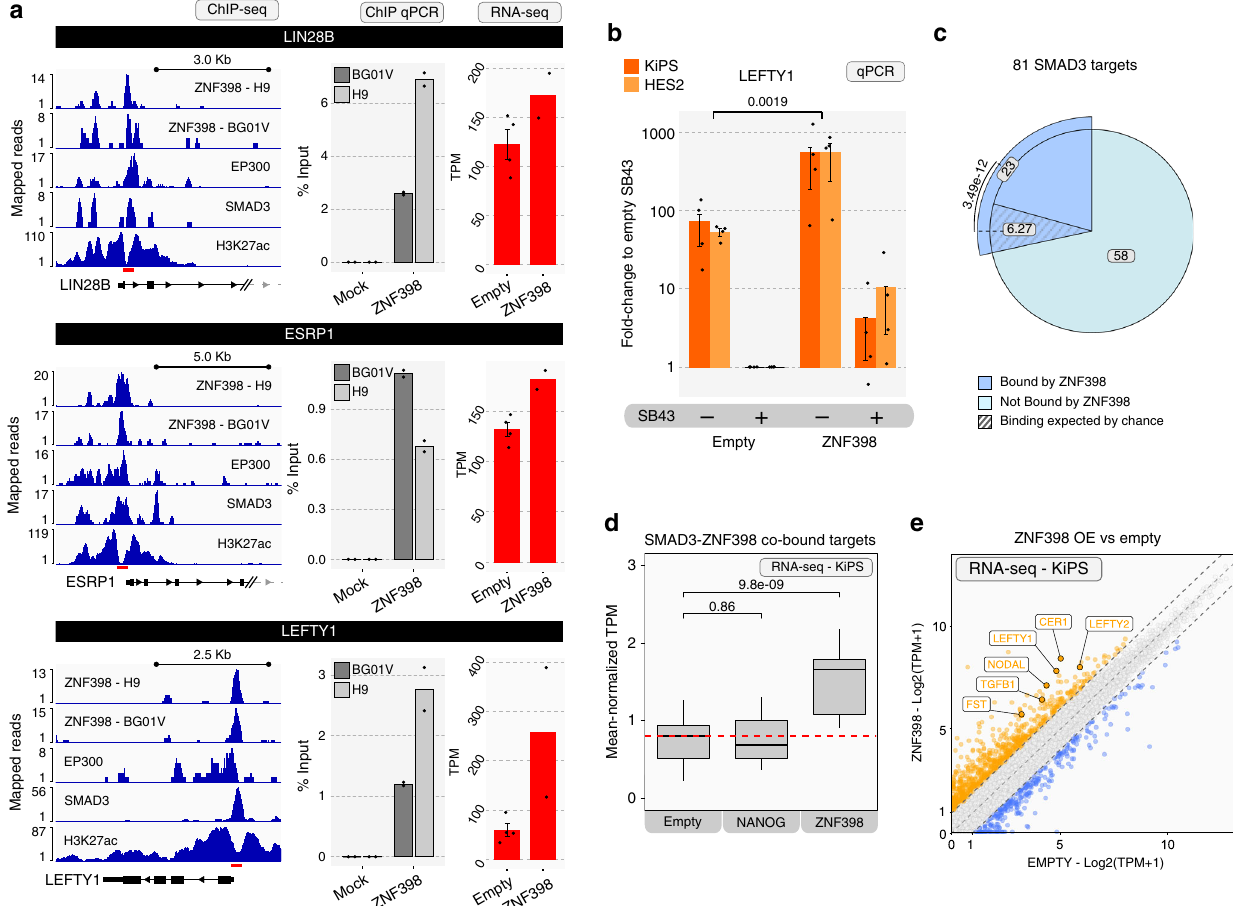
Fig. 7 ZNF398 boosts TGF-beta signal. a Left: Gene tracks of ZNF398 in two different hPSC lines (H9 and BG01V), EP300, SMAD3, and H3K27ac. Middle: Barcharts of ChIP-qPCR for ZNF398 performed in BG01V (dark grey) and H9 (light grey) cell lines on LIN28B, ESRP1 and LEFTY1 loci. Enrichment is expressed as a percentage of the DNA inputs. Bars indicate the mean of two biological replicates shown as dots. Right: RNA-seq of hPSCs (KiPS) stably expressing an empty vector (Empty) or ZNF398. Bars indicate the mean ± SEM of independent experiments shown as dots ( n = 4 and n = 2 in Empty and ZNF398 overexpressing cells, respectively). Absolute expression is reported as TPM. Source data are provided as a Source Data fi le. b LEFTY1 levels measured by qPCR of HES2 (light orange bars) and KiPS (dark orange bars) stably expressing an empty vector or ZNF398, untreated or treated with SB43 for 5 days. Bars indicate the mean ± SEM of independent experiments shown as dots ( n = 4). Expression was normalised to the Empty SB43 samples and shown on a logarithmic scale. Unpaired two-tailed Mann – Whitney U test. Source data are provided as a Source Data fi le. c Pie-chart representing the 81 SMAD3 direct targets UP-regulated by TGF-beta induction identi fi ed in Fig. 1c. In dark blue are shown the 23 SMAD3 targets that are also bound by ZNF398. Such co-binding is signi fi cantly higher ( p -value = 3.49e − 12, Chi-squared test) than the one expected by chance, shown as the slice fi lled with diagonal lines. d Mean-normalised expression levels of the 23 genes bound by ZNF398 and SMAD3. Shown data derived from RNA-seq analysis of KiPS stably expressing an empty vector, NANOG (serving as a control) or ZNF398. For each gene, data was normalised to the mean-expression across the three samples. Box plot indicates 25th, 50th and 75th percentile; whiskers indicate minimum and maximum. Unpaired two-tailed t -test. e Scatter plot showing RNA-seq data from KiPS stably expressing an empty vector (Empty) or ZNF398. DOWN-regulated (Log2FC < − 1) and UP-regulated (Log2FC > 1) genes are indicated in blue and orange